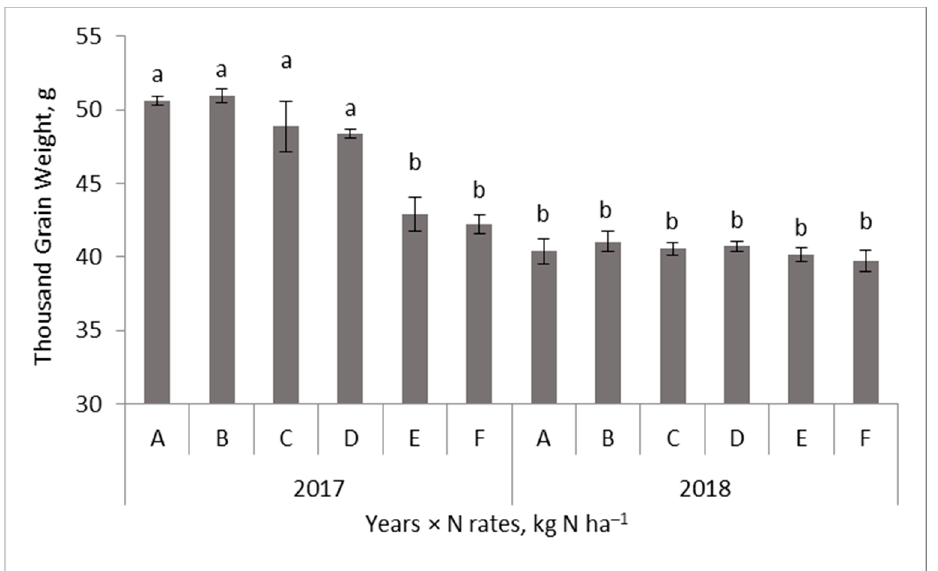
Figure 3. Effect of plant protection methods on thousand grain weight of winter wheat. Similar letters indicate a lack of significant differences between experimental treatments using Tukey’s test. The vertical bar in the column is to the standard error of the mean.